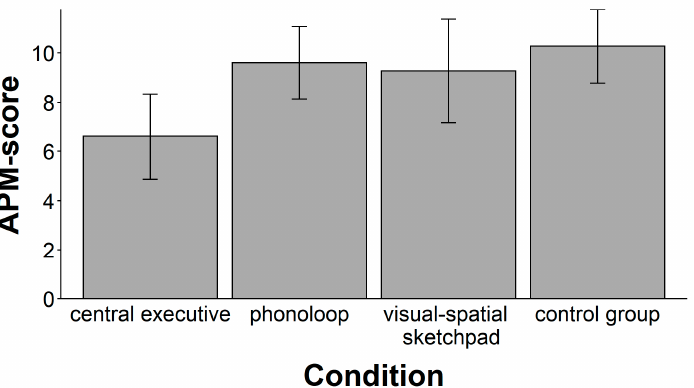
Figure 1. Mean APM performance in the four different groups. Whiskers indicate 95% confidence intervals.